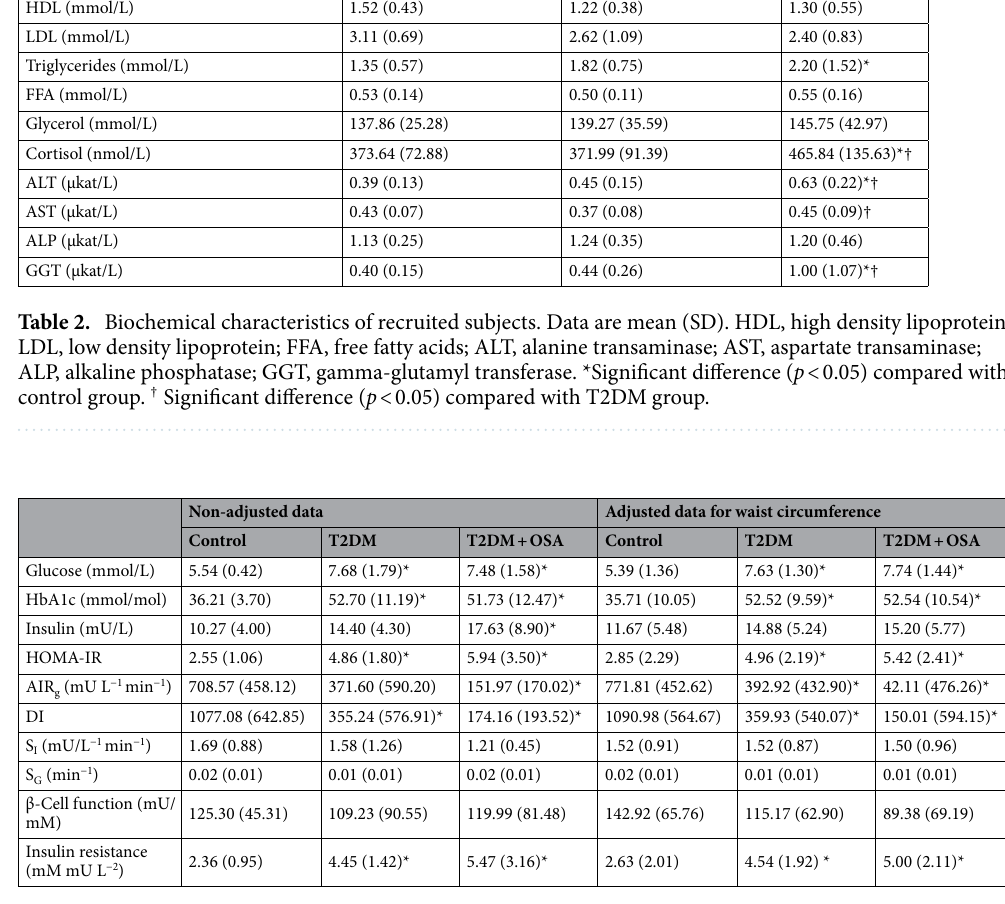
Table 3. IVGTT results. Data are mean (SD). HbA1c = glycated haemoglobin. HOMA-IR = homeostatic model assessment for Insulin resistance. AIR g —acute insulin response to glucose. DI—disposition index. S I = insulin sensitivity. S G = glucose effectiveness. *Significant difference ( p < 0.05) compared with control